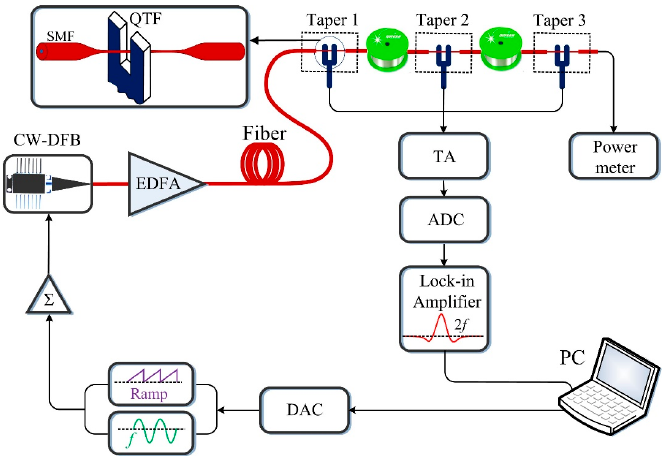
Figure 11. Schematic of the FEW-QEPAS sensor.